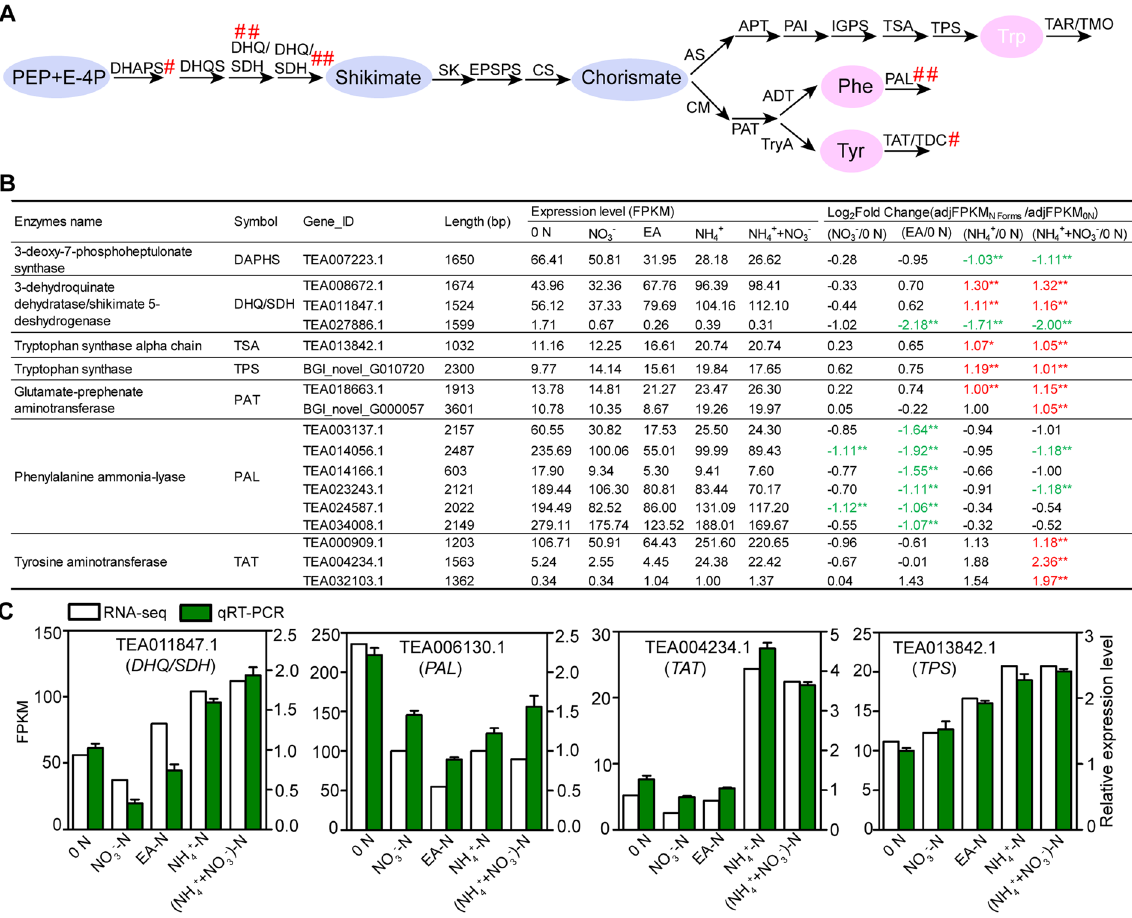
Figure 7. Identification of DEGs encoding enzymes related to phosphoenolpyruvate/shikimate pathway. ( A ) The DEGs encoding enzymes related to synthesis and first step degradation pathway of amino acids from phosphoenolpyruvate/shikimate pathway. ( B ) The expression levels and relative fold change (log 2 [ adj FPKM N forms / adj FPKM 0 N ]) of DEGs related to amino acids from phosphoenolpyruvate/shikimate pathway. The table indicates genes with significant changes (fold change ≥ 2, p < 0.05; marked by two asterisks and number in red or green) in 0 N versus different N forms. 0 N, N free; NO 3 − , NO 3 − -N, EA, Ethylamine-N; NH 4 + , NH 4 + -N; (NH 4 + + NO 3 − ), (NH 4 + + NO 3 − )-N. ( C ) Quantitative real-time PCR validation for potential candidate genes. The relative expression levels and FPKM values are